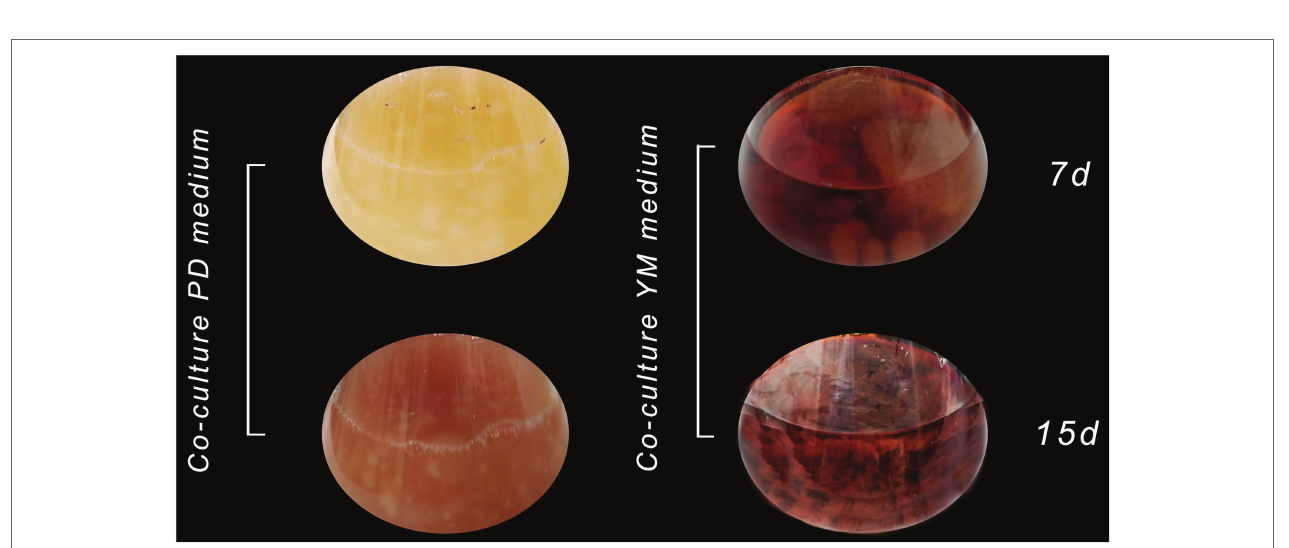
FIGURE 7 | Antagonist activity between each pair of endophytic fungal strains in YM agar. (A,B) Anexic culture of Xylaria sp. (1) and D. endophytica (5). (C) Xylaria sp. (1) against the four strains being assessed. (D) D. endophytica (5) against the four strains being assessed.